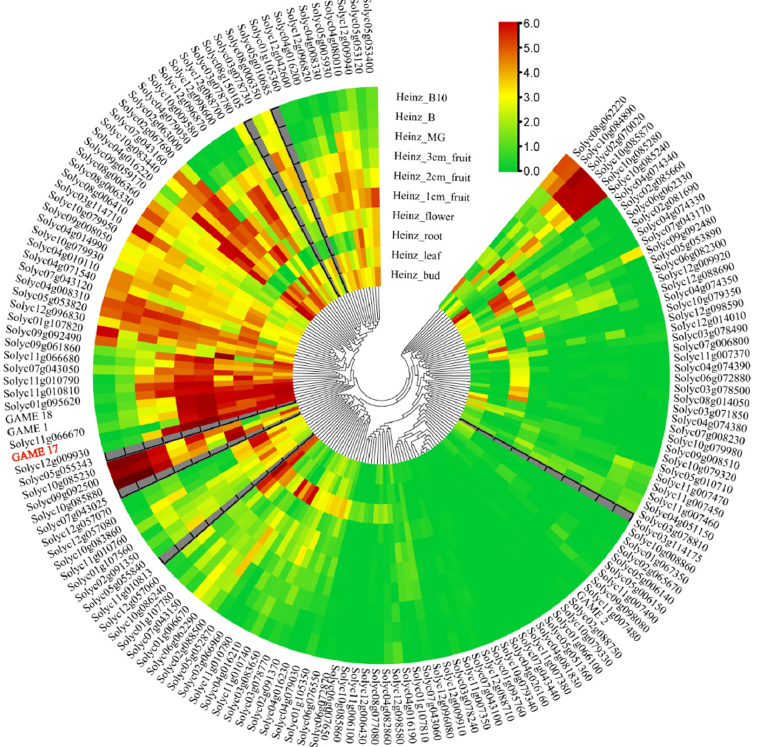
Figure 4. Expression pattern of SlUGT genes in different organs of S. lycopersicum based on the published RNA-seq data, GAME 17 was marked by red.